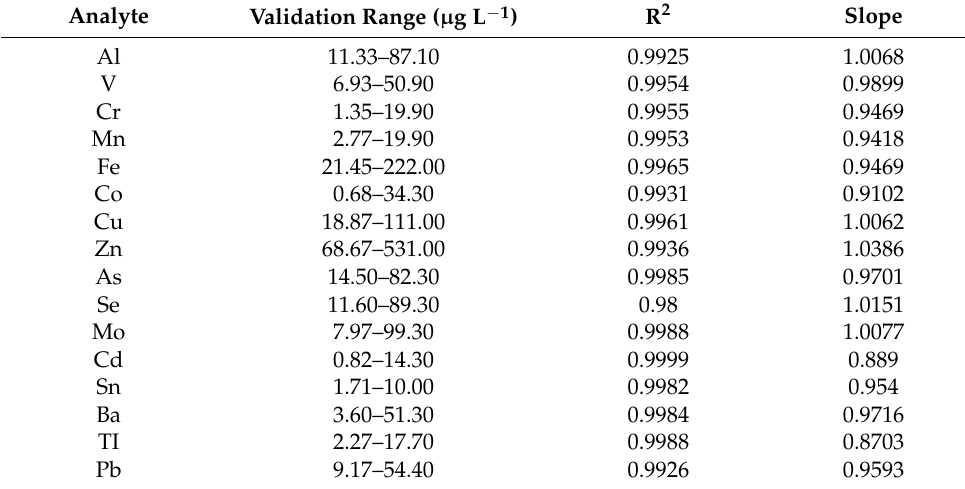
Table 5. Linearity, slope and validation range of urine